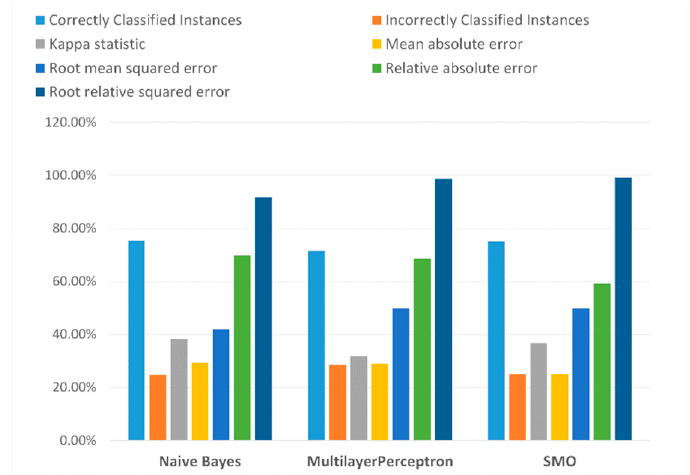
Table 1. Algorithms model building time.